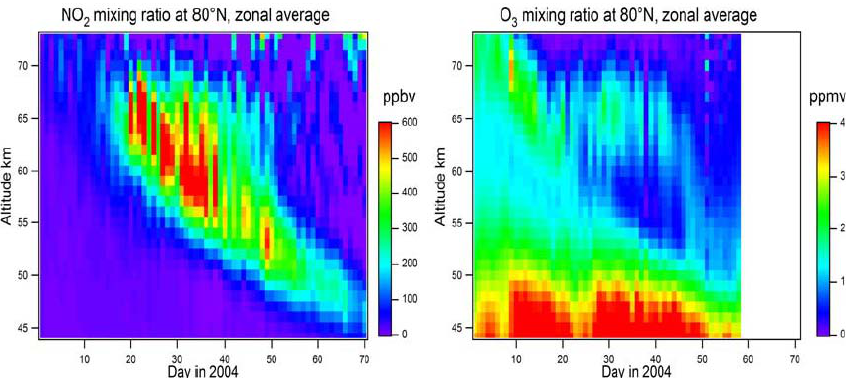
Fig. 31. Evolution of zonal averaged mixing ratio of NO 2 (left) and O 3 (right) at 80 ◦ N from GOMOS data between 1 January and 10 March 2004 (from Hauchecorne et al., 2007).